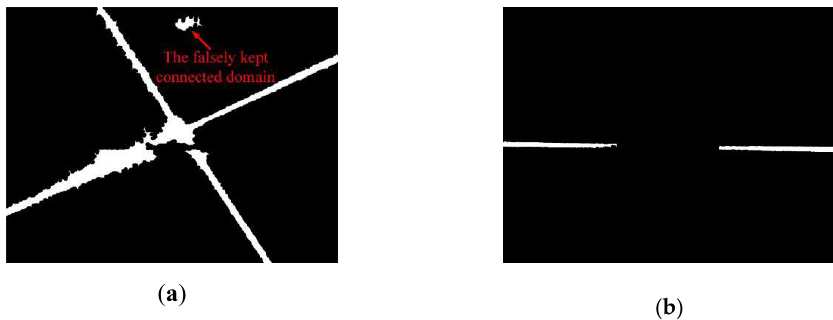
Figure 7. Kept connected domains. ( a ) Laser stripe region. ( b ) Joint region.